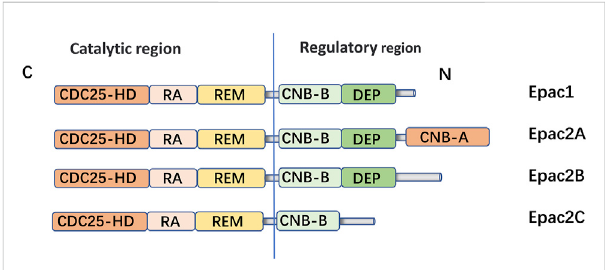
Domain architecture of EPAC isoforms: EPAC proteins are single polypeptide molecules which consist of an N-terminal regulatory region and a C-terminal catalytic region. The catalytic region at the C terminus is mainly composed of three structural and: Ras exchange motif (REM), Ras association (RA), CDC25 homology domain [also known as the guanine nucleotide exchange factor for Ras-like small GTPases (RasGEF) domain] responsible for nucleotide exchange activity. The two subtypes had different structures in the N-terminal regulatory region. The Epac2A regulation region contains two CAMP-binding domains, CNB-B and CNB-A. However, Epac1, Epac2A and Epac2B all have Disheveled/Egl-10/pleckstrin (DEP) domains, which are correlated with subcellular localization of Epac. Epac1 is widely expressed inhuman tissues,such as thehippocampus, thyroid, breast, and lung. EPAC2A is mainly expressed in the